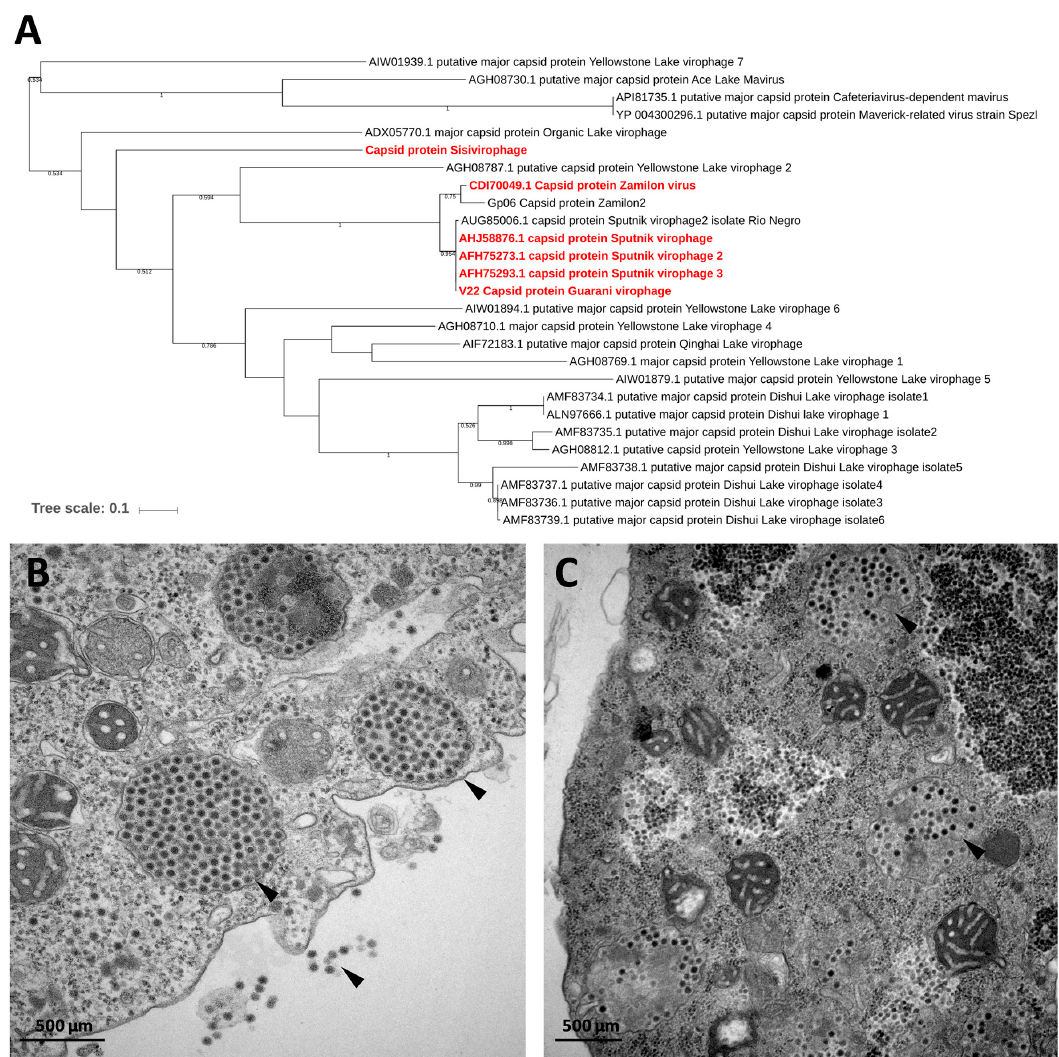
Figure 6. ( A ) Phylogenetic reconstruction based on the major capsid proteins of virophages. The virophages isolated in IHU are highlighted in red. The analysis was performed using MEGA version 7.0, applying the maximum-likelihood method and WAG model of evolution with 500 bootstrap replicates (cutoff ≥ 50). ( B – C ) Transmission electronic microscopy of virophage particles replicating in Acanthamoeba castellanii co-infected with a giant virus host (arrows). (B) Sputnik; (C) Zamilon.